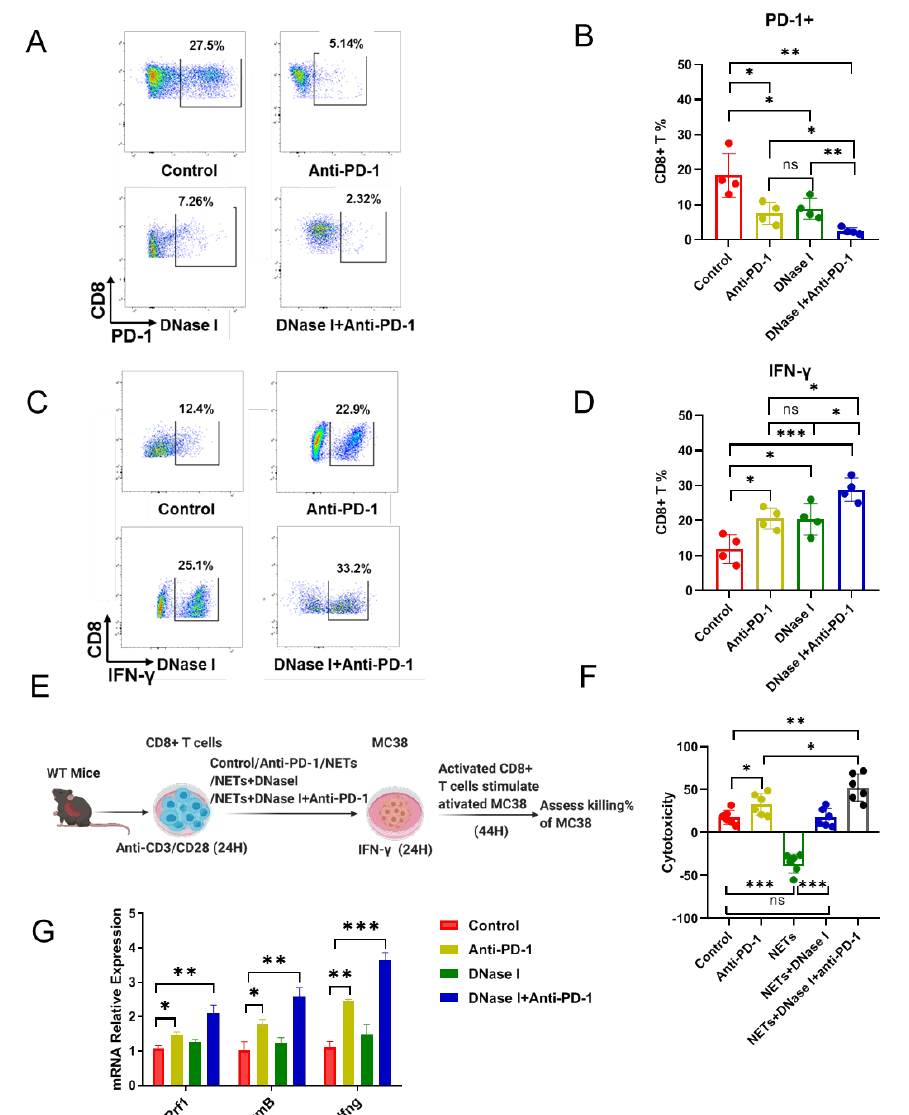
Figure 4. NETs induce the resistance to anti-PD-1 via predisposition to the cytotoxicity of CD8+ T cells. ( A , B ) Percentages of PD-1+ CD8+ T cells within the tumors from mice undergoing different treatments; n = 4 mice/group. ( C , D ) Percentages of IFN- γ + CD8+ T cells within the tumors from mice undergoing different treatments; n = 4 mice/group. ( E ) Experiment outline. Anti-CD3- and anti-CD28-primed CD8+ T cells were stimulated with control or anti-PD-1 (25 µ g/mL) or isolated NETs (from 2 × 10 6 neutrophils/mL) or isolated NETs + DNase I (100U/mL) for 24 h with anti- CD3 and anti-CD28, then these stimulated CD8+ T cells were co-incubated with MC38 tumor cells. ( F ) Relative killing by CD8+ T cells of MC38 with different treatments. ( G ) Relative mRNA levels of Prf1 , Gzmb , and Ifng in CD8+ T cells with different treatments. The graphs show the means ± SD. ANOVA was performed with adjustment for multiple comparisons for ( B , D , F , G ). Note: * p < 0.05, ** p < 0.01, *** p < 0.001; NS: not significant. All statistical tests used in this figure were two-sided and p < 0.05 was considered statistically